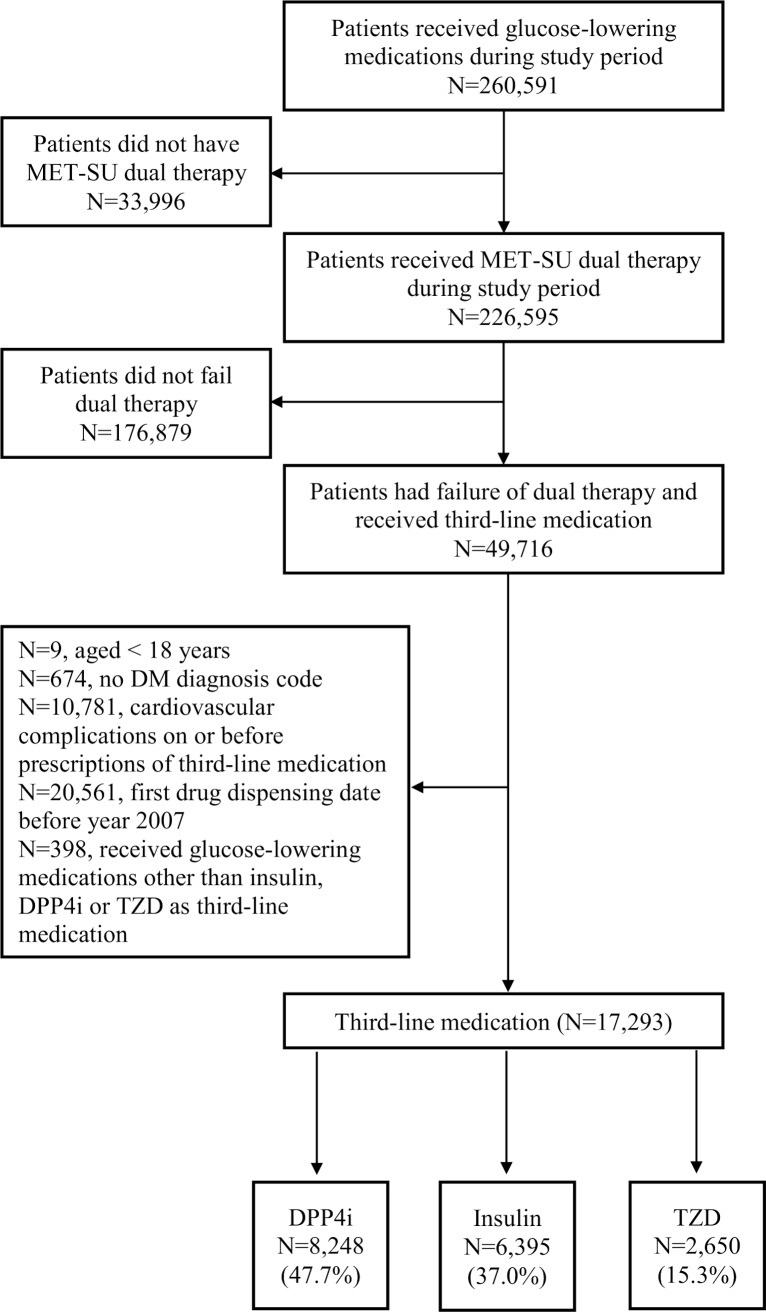
Enrolment of patients who had failure of Met-SU dual therapy and received DPP4i, insulin, or TZD as third-line medications.DM, diabetes mellitus; DPP4i, dipeptidyl peptidase-4 inhibitor; Met-SU, metformin-sulfonylurea; TZD, thiazolidinedione.